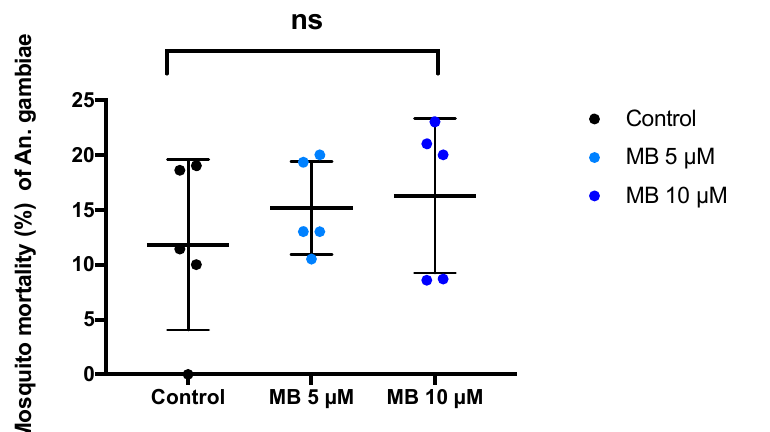
Figure A1. Mosquito mortality rate post-feeding is presented as mean and standard deviation. Data from five independent experiments are presented. The black lines represent the mean and standard deviation. p = 0.48 for comparisons of MB 5 µM vs. control; p = 0.23 for comparisons of MB 10 µM vs. control.